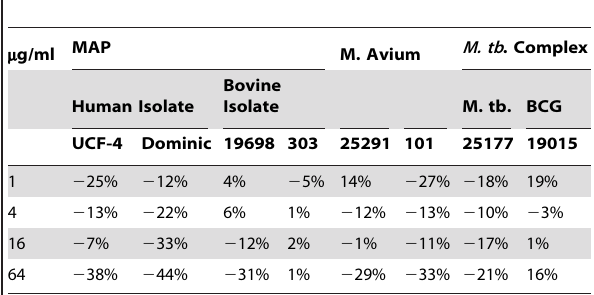
Table 5. Vitamin E DL- a -Tocopherol Acetate.